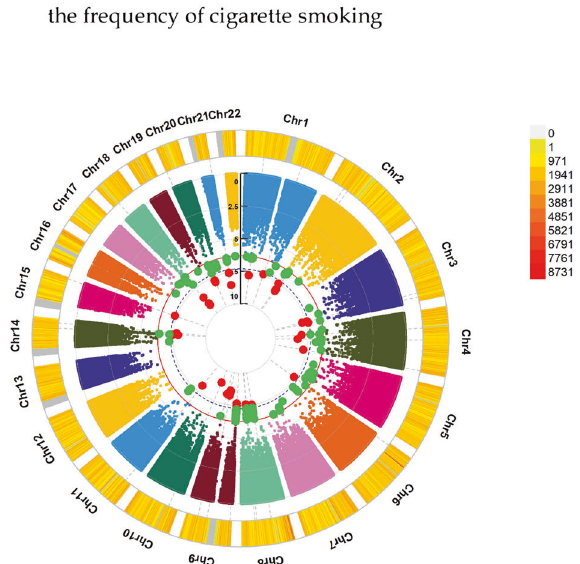
Fig. 4 Chromosomal regions interacting with sexually molested as a child for the frequency of cigarette smoking. *From the center, the circos depicts the − log 10 P values of each variant. Red plots represent the P value < 5 × 10 − 8 and green plots represent P value < 5 × 10 − 7 . The plots were generated using the “ CMplot ” R script